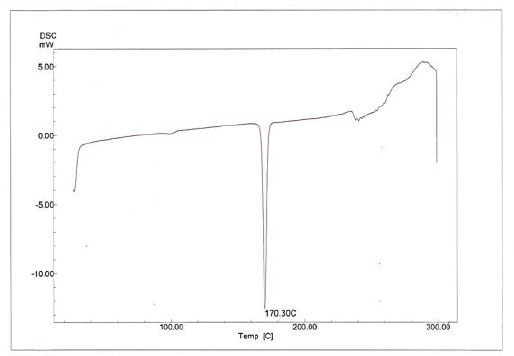
Figure 1. Differential scanning calorimetry of isradipine.